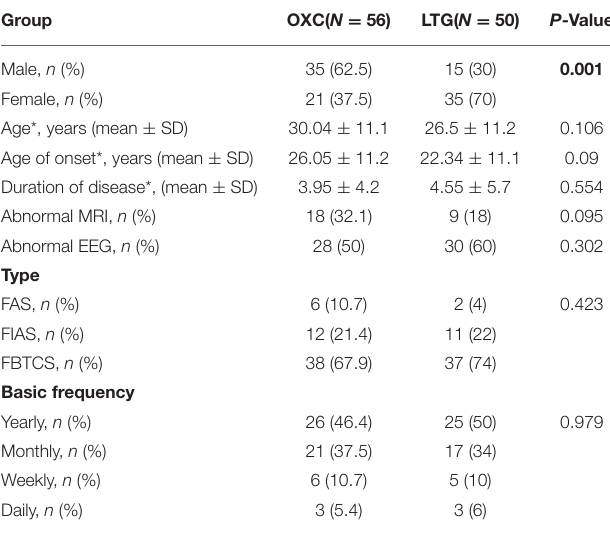
TABLE 1 | Clinical characteristics of participants receiving lamotrigine or oxcarbazepine